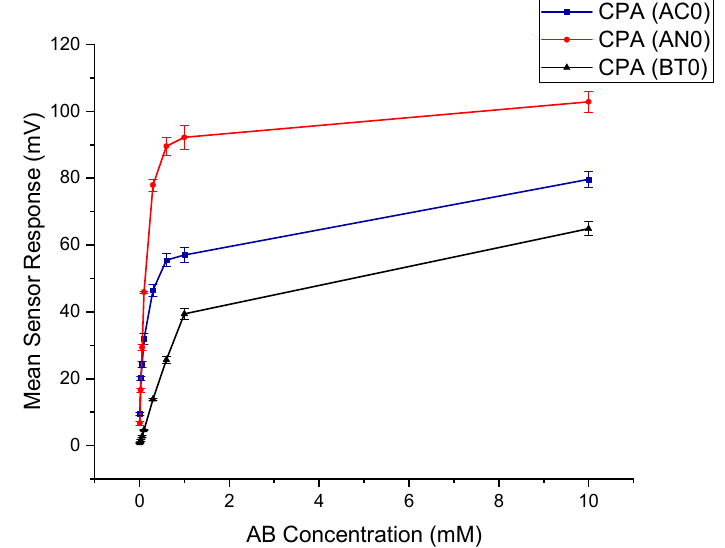
Figure 3. Dose response curve representing aftertaste of amlodipine besylate as tested by AC0, AN0 and BT0.